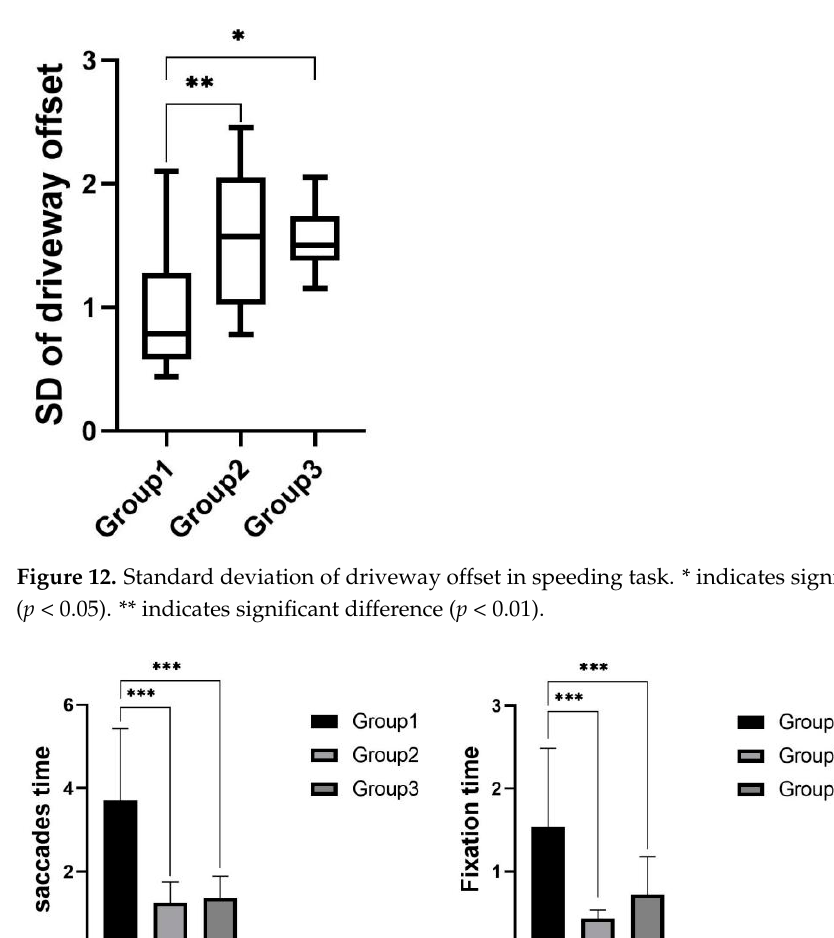
Figure 14. Workload in speeding task. ** indicates significant difference ( p < 0.01). *** indicates significant difference ( p < 0.001).